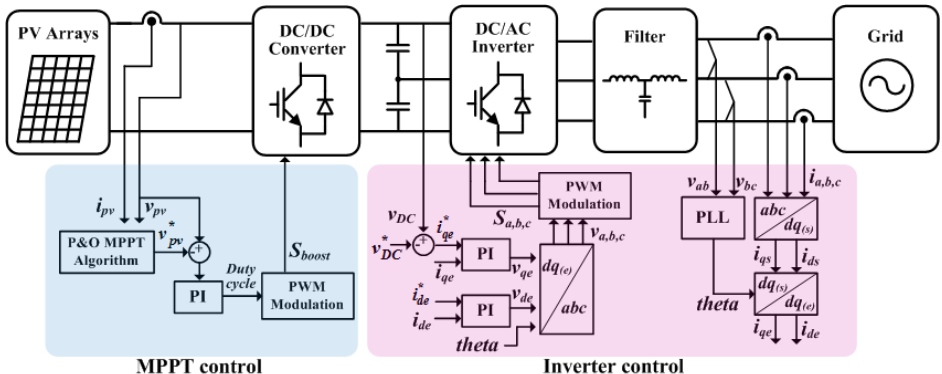
Figure 1. Configuration and control structure of two-stage three-phase PV system (PI – proportional integral, PLL – phase-locked loop, PWM – pulse width modulation, S – switching function). Depending on the application and power rating, the DC/DC converter is included or not.